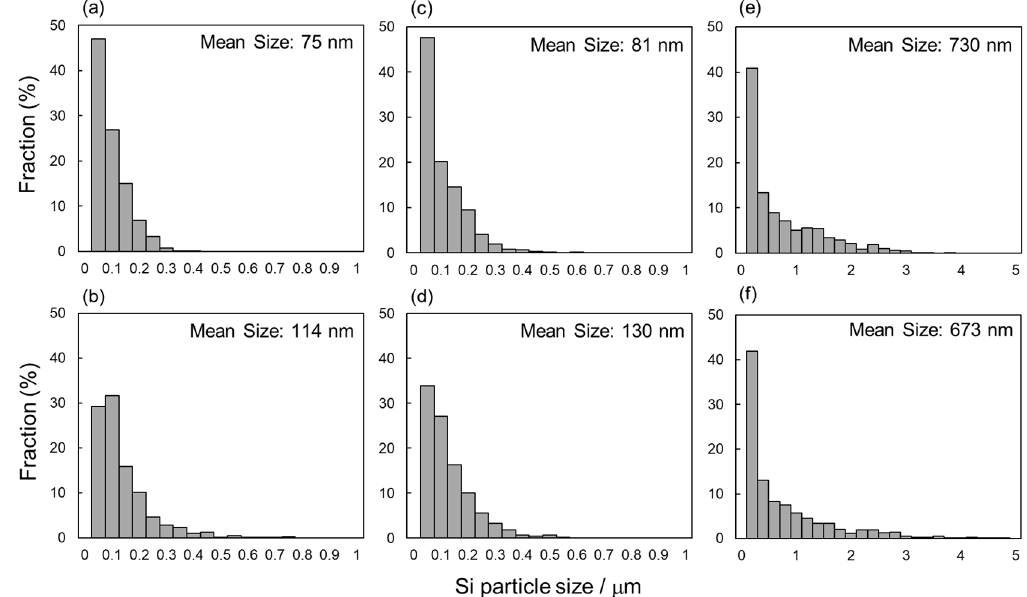
Figure 12. Si particle size distribution measured from the strut portion of the lattice specimen with different vertical distances from the geometric center: ( a , c , e ) d S = 0.2 mm, ( b , d , f ) d S = − 0.3 mm; ( a , b ) as-manufactured, ( c , d ) annealed at 300 °C for 2 h, and ( e , f ) solution heat treated at 530 °C for 6 h.